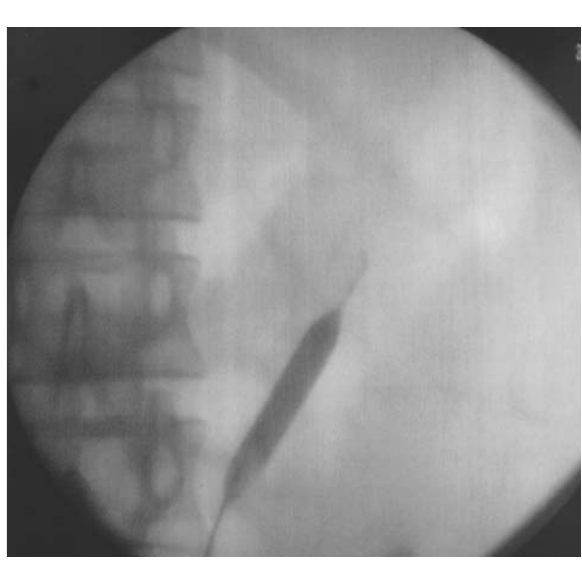
Figure 5 – Balloon dilatation is performed.